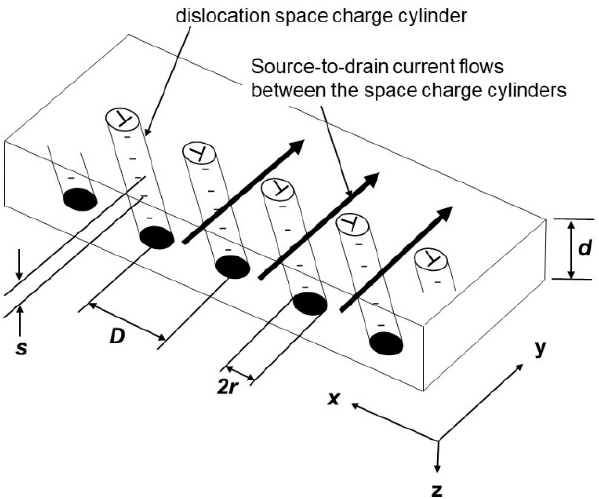
Figure 19. A new model of the current flow across a sub-B between dislocation space charge cylinders in the perpendicular